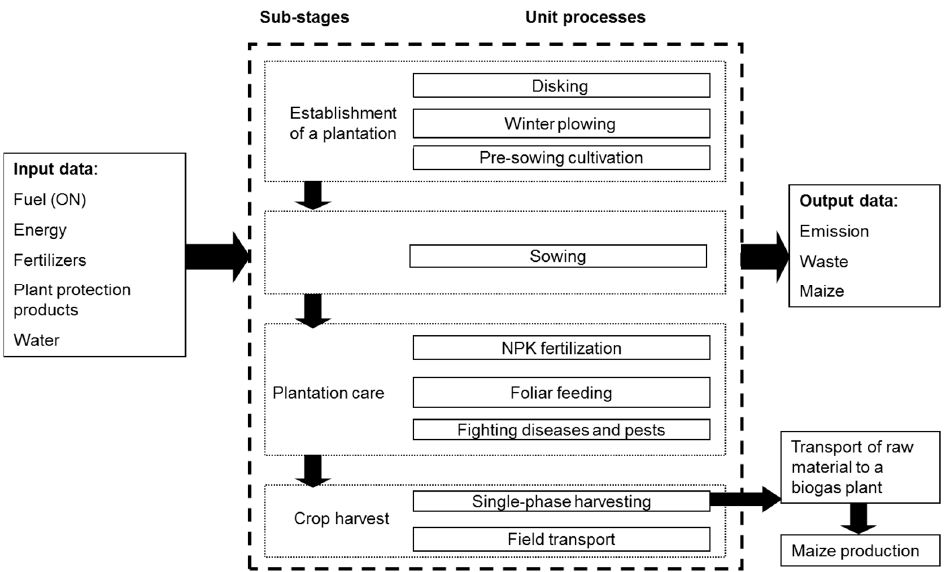
Figure 3. General flow chart covering the system boundaries and the unit processes of the maize growing and silage stage.